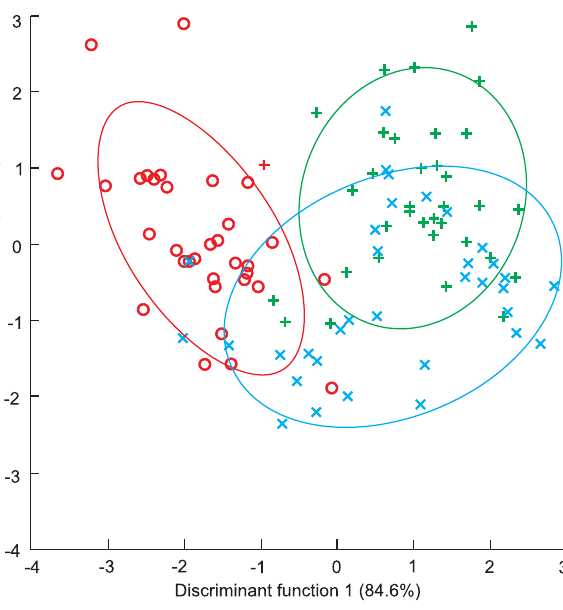
Figure 11. Graphic depiction of the discriminant analysis of mor- phometric variables of three Happiella cf. insularis samples collected from the Jararaca ( (cid:123) ), Caxadaço ( (cid:177) ), and Parnaioca ( (cid:171) ) trail areas, Ilha Grande, RJ,